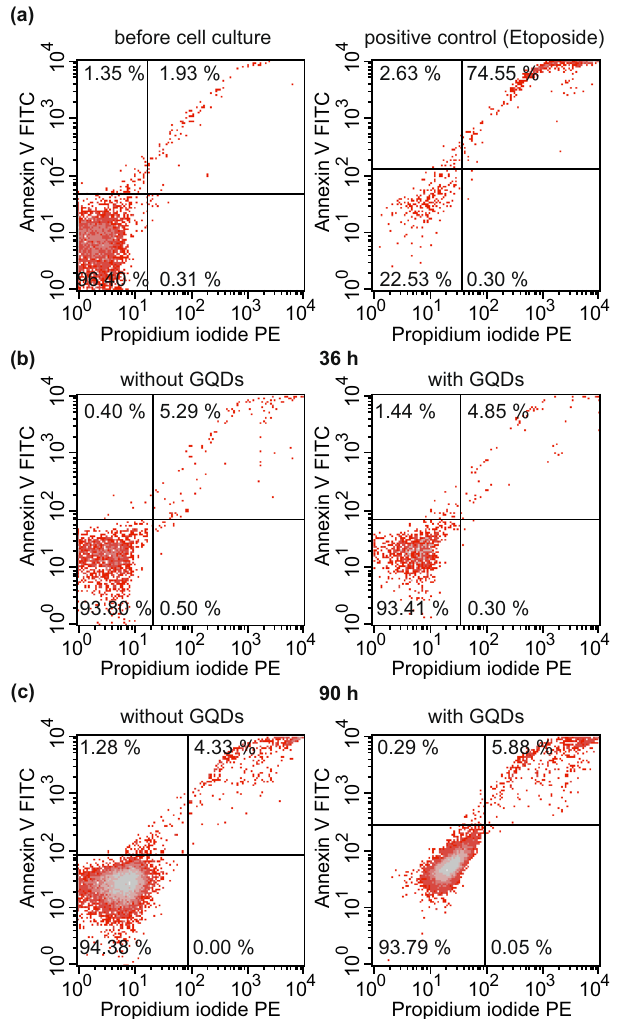
Figure 6. Annexin apoptosis assay for ( a ) untreated CD34 + cells before cell culture (left) and a positive control using Etoposide as an apoptosis inducing agent (right), ( b ) CD34 + cells cultivated for 36 h without (left) and with GQDs (right) and ( c ) CD34 + cells cultivated for 90 h without (left) and with GQDs (right). Shown is one representative example out of 3 independent